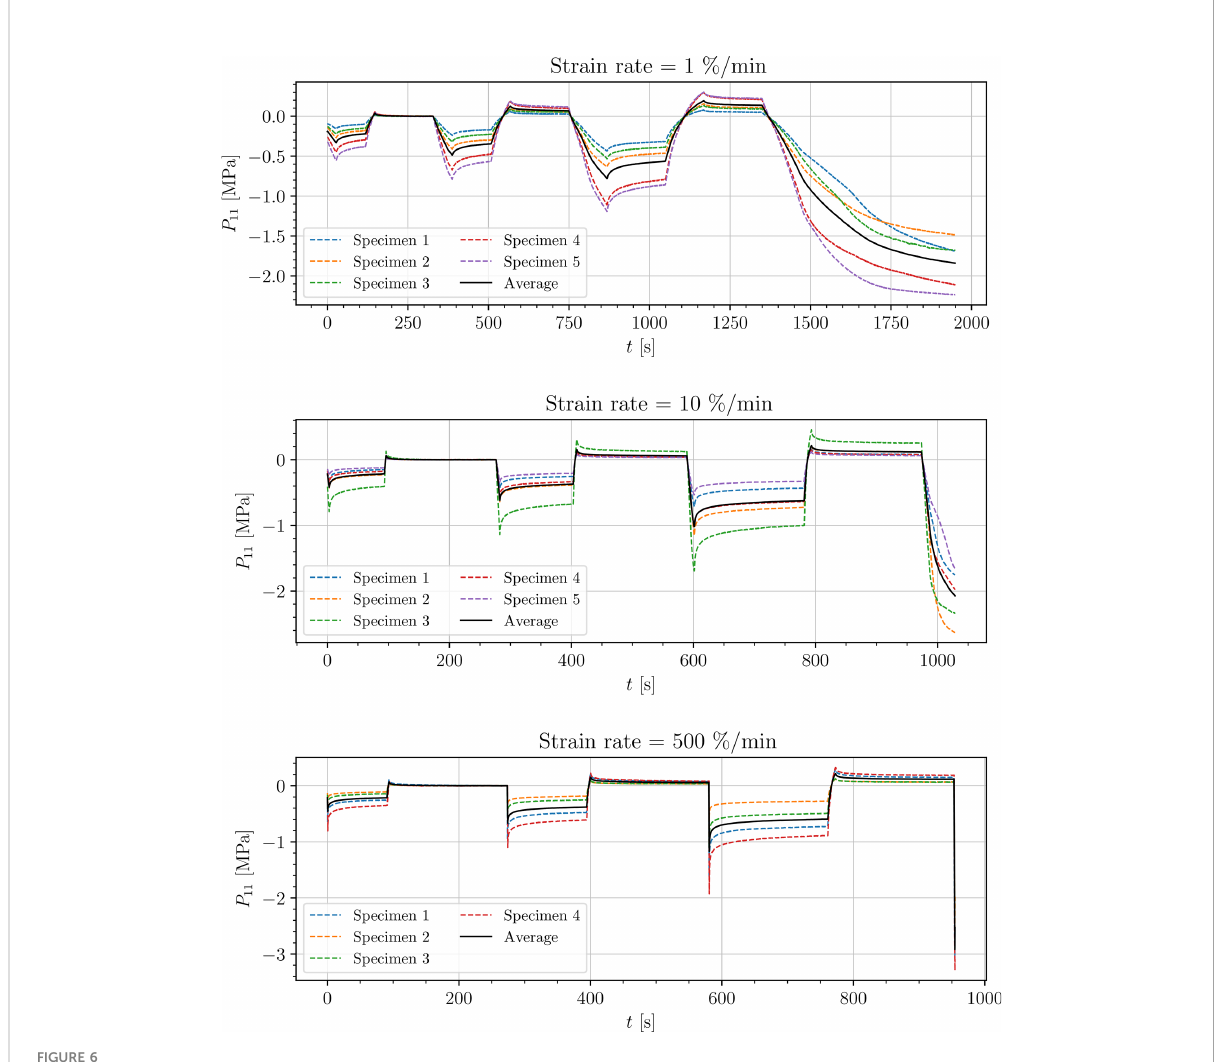
FIGURE 6 Uniaxial cyclic compression stress-relaxation test of